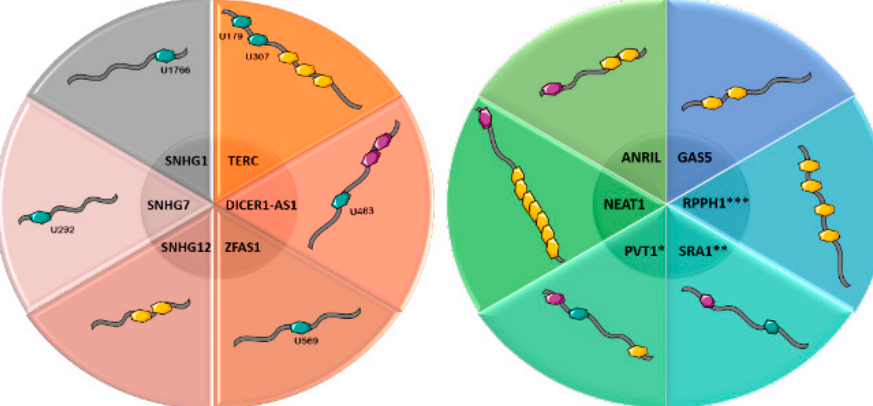
Figure 2. RNA modifications and their positions (where known), occurring in some lncRNAs: TERC, DICER-AS1, ZFAS1, SNHG12, SNHG7, SNHG1, GAS5, RPPH1, SRA1, PVT1, NEAT1, ANRIL. *For